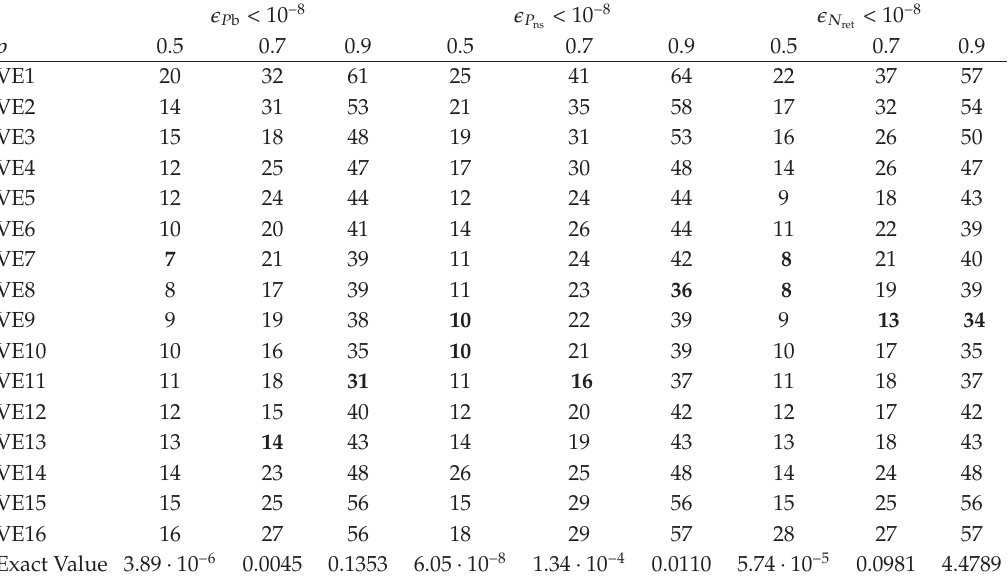
Table 2: Minimum value of Q to obtain relative errors (cid:5) (cid:9) (cid:6) lower than 10 − 8 .